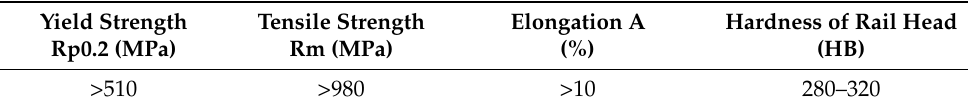
Table 2. Mechanical properties of U75V rail steel.